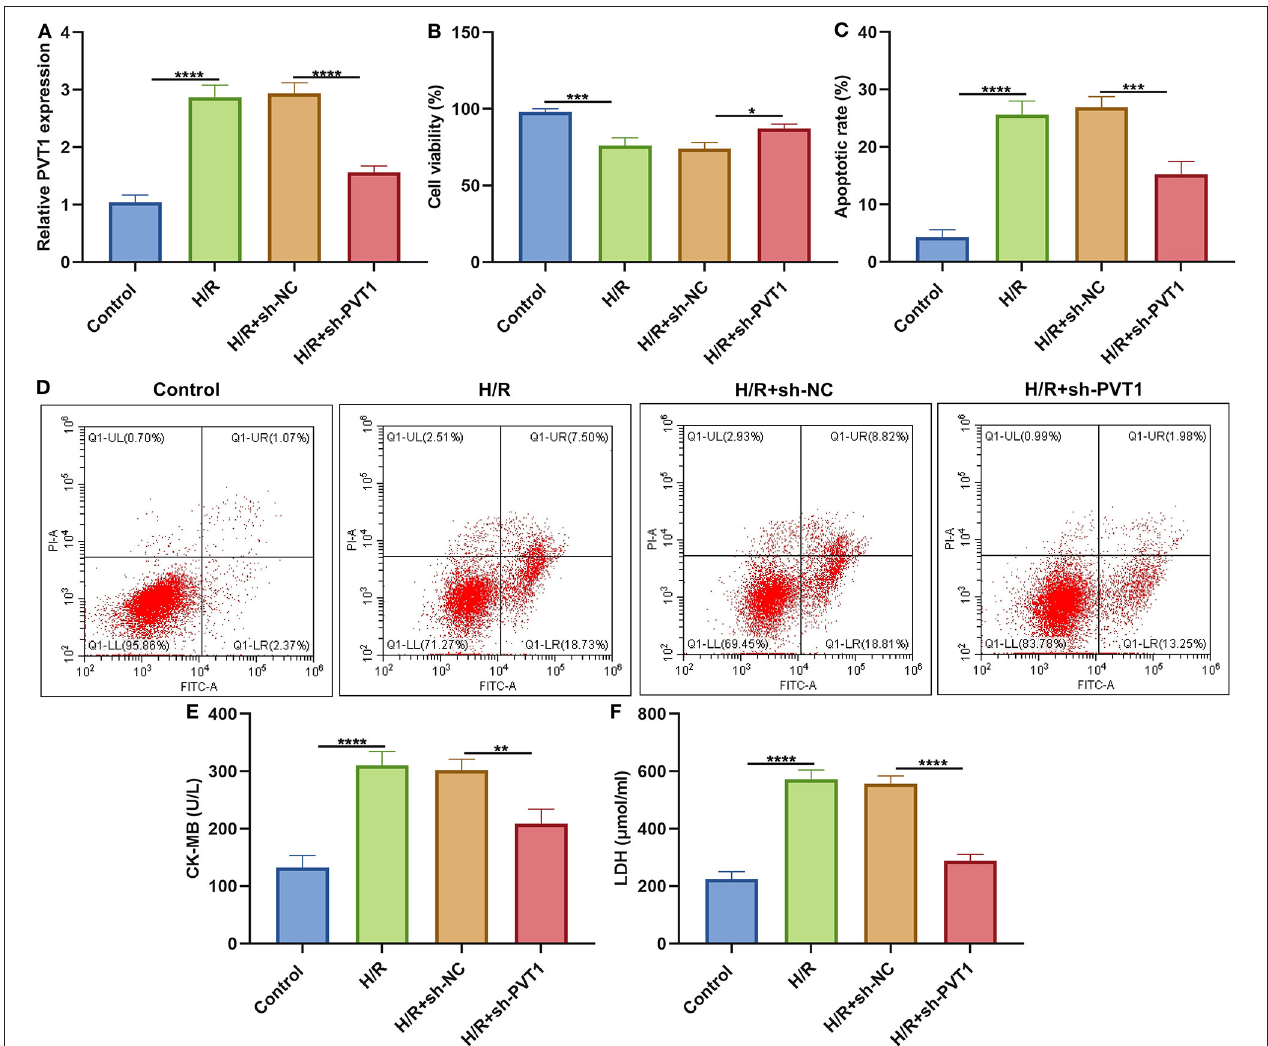
FIGURE 6 | LncRNA PVT1 knockdown alleviates H/R-induced apoptosis in H9C2 cells. (A) RT-qPCR of PVT1 expression in H9C2 cells in four groups: control, H/R, H/R + sh-NC, and H/R + sh-PVT1 groups. H9C2 cells in the H/R, H/R + sh-NC, and H/R + sh-PVT1 groups were treated by H/R for 4h. For the H/R + sh-NC or H/R + sh-PVT1 groups, H9C2 cells (5 × 10 4 ) were transfected by 1 µ g sh-NC or 1 µ g sh-PVT1 for 48h. No treatment was done for H9C2 cells in the control group. (B) CCK-8 for the cell viability of H9C2 cells in above groups. (C,D) Flow cytometry of apoptotic levels of H9C2 cells in each group. (E,F) ELISA of the levels of CK-MB and LDH in the supernatant of H9C2 cells in above groups. Each experiment was repeated three times. * p < 0.05; ** p < 0.01; *** p < 0.001; **** p <